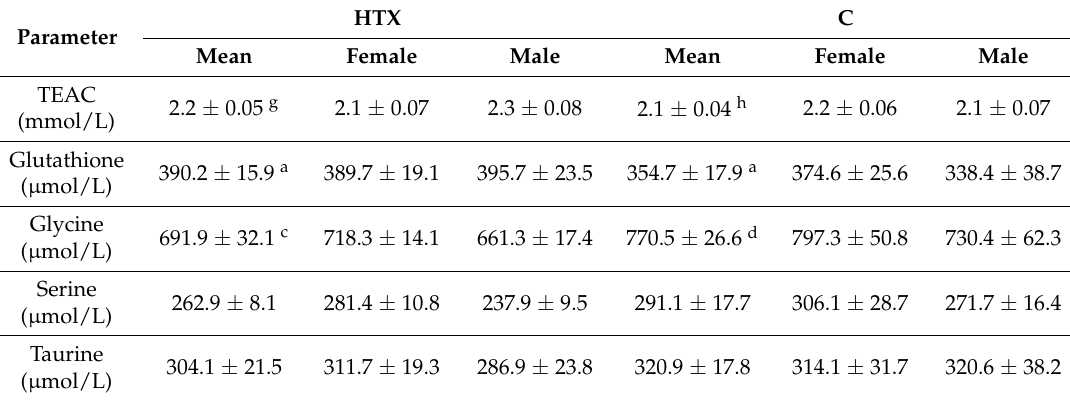
Figure 1. Relative gene expression of antioxidant, vascularization and fetal growth candidate genes in placenta of Iberian fetus from sows supplemented with hydroxytyrosol (HTX) and controls (C). Table 2. Fetal antioxidant status at day of sampling (Day 100 of pregnancy). Mean values ( ± SEM) and differences for sexes in treated (Hydroxytyrosol; Group HTX) and control fetuses (Group C). TEAC accounts for Trolox Equivalent Antioxidant Capacity. Superscript letters indicate significant differences between groups: a (cid:54) = b: p < 0.9, c (cid:54) = d: p < 0.05, e (cid:54) = f: p < 0.01, g (cid:54) = h: p <